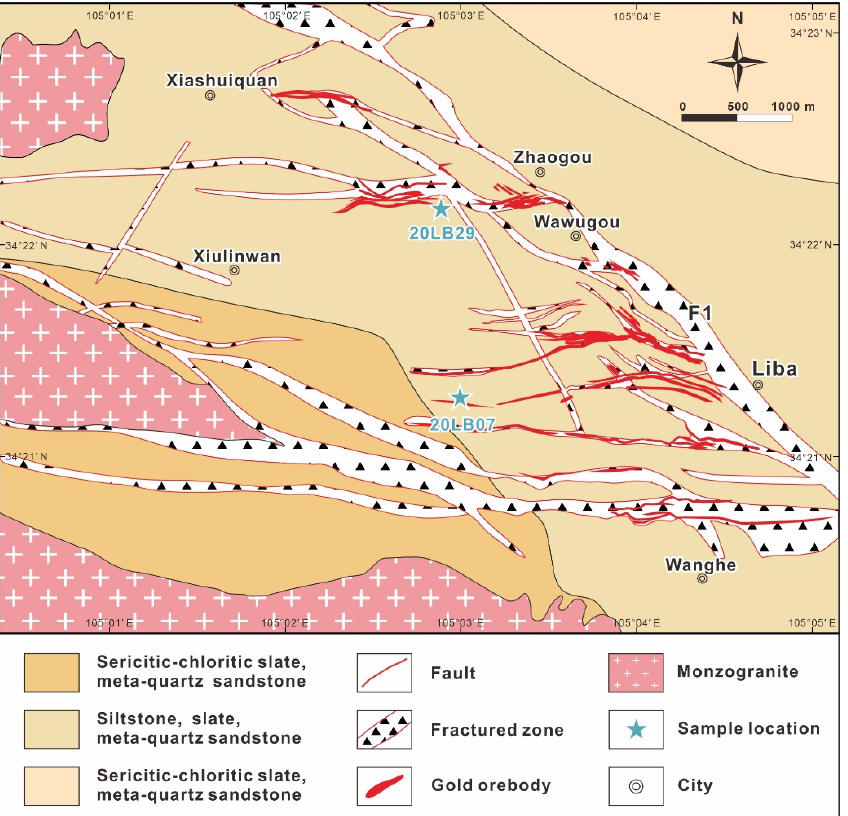
Figure 2. Geological map of the Liba gold deposit showing the major geological units and sample locations.